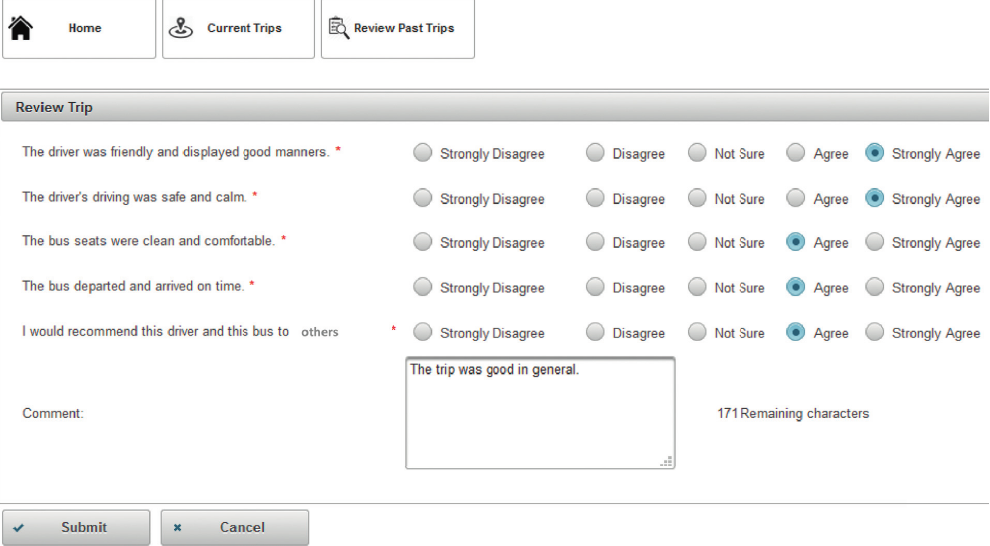
Figure 12: The review trip form in the passenger